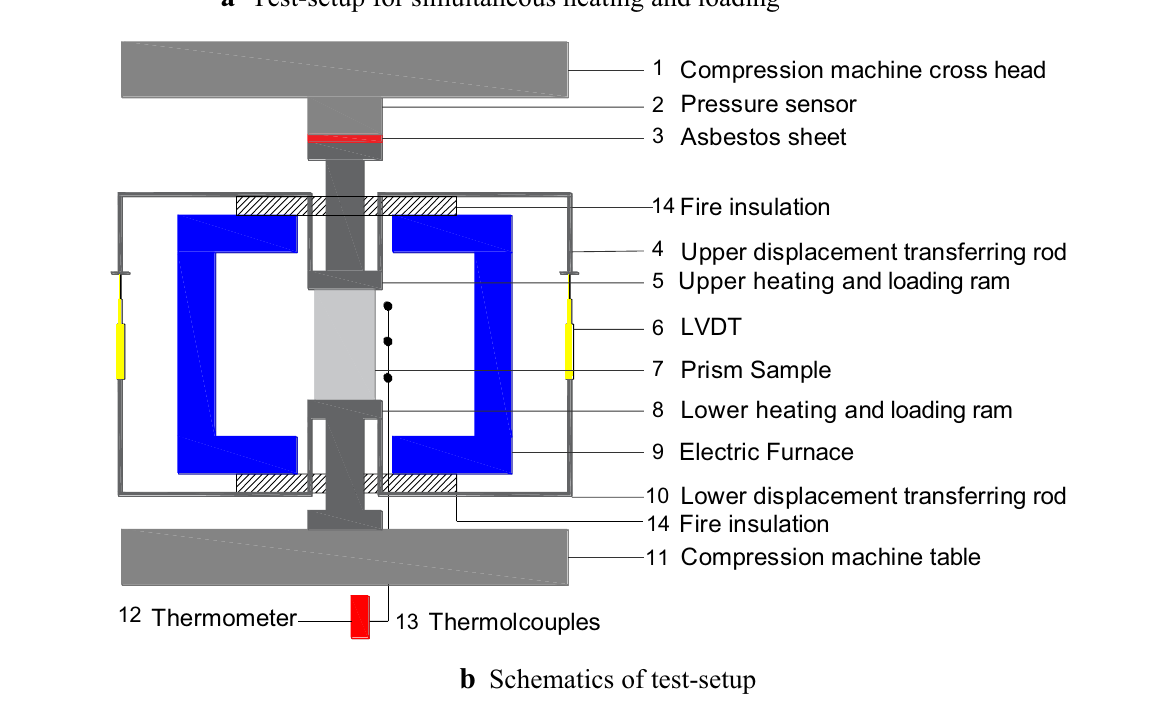
Fig. 2 Experimental apparatus used in this